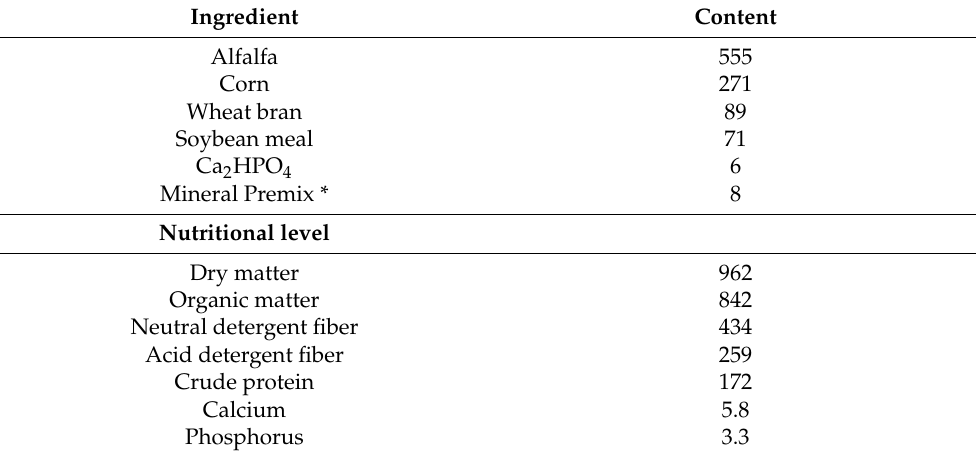
Table 1. Ingredients and nutritional level of basal diet offered to goats. Ingredient Content